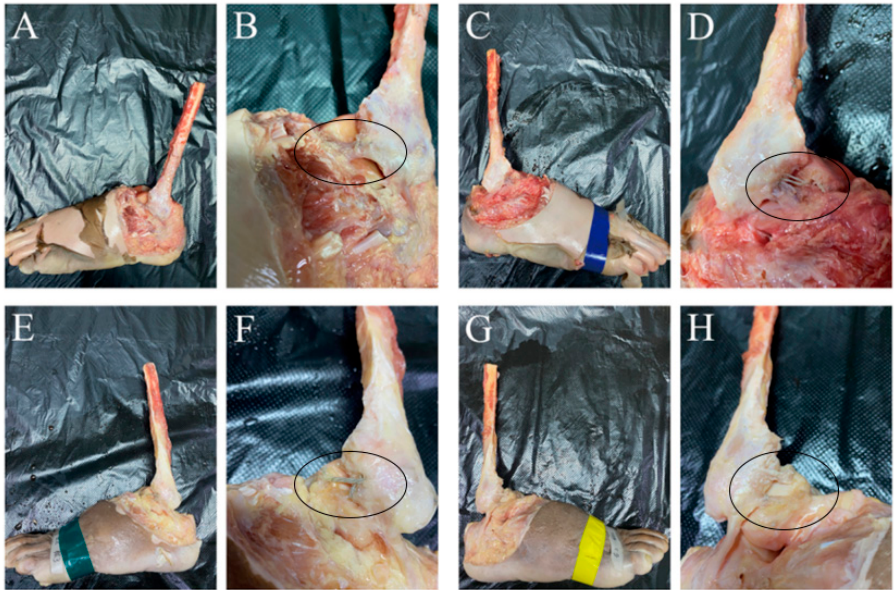
Figure 5. Separation of ATFL. ( A , B ): Ankle specimens of the normal group after separation. ( C , D ): Ankle specimens of the suture augmentation group after separation. ( E , F ): Ankle specimens of the plus suture augmentation group after separation. ( G , H ): Ankle specimens of the biological augmentation group after separation.